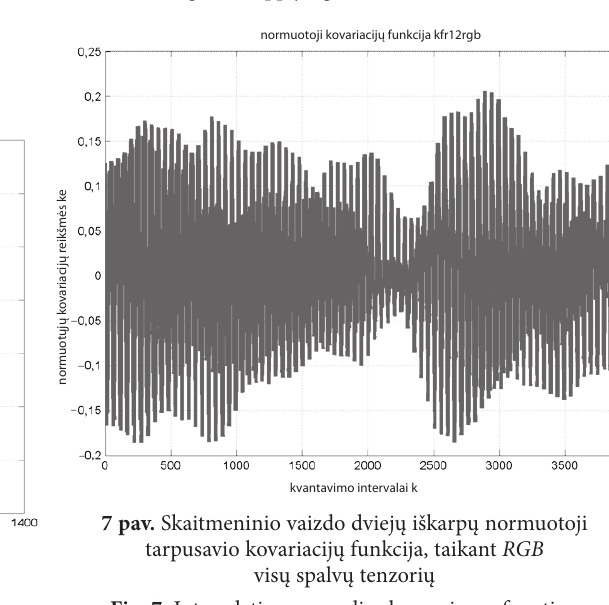
Fig. 4. Normalised covariance function of the Digital image 1st fragment, applying RGB red colour